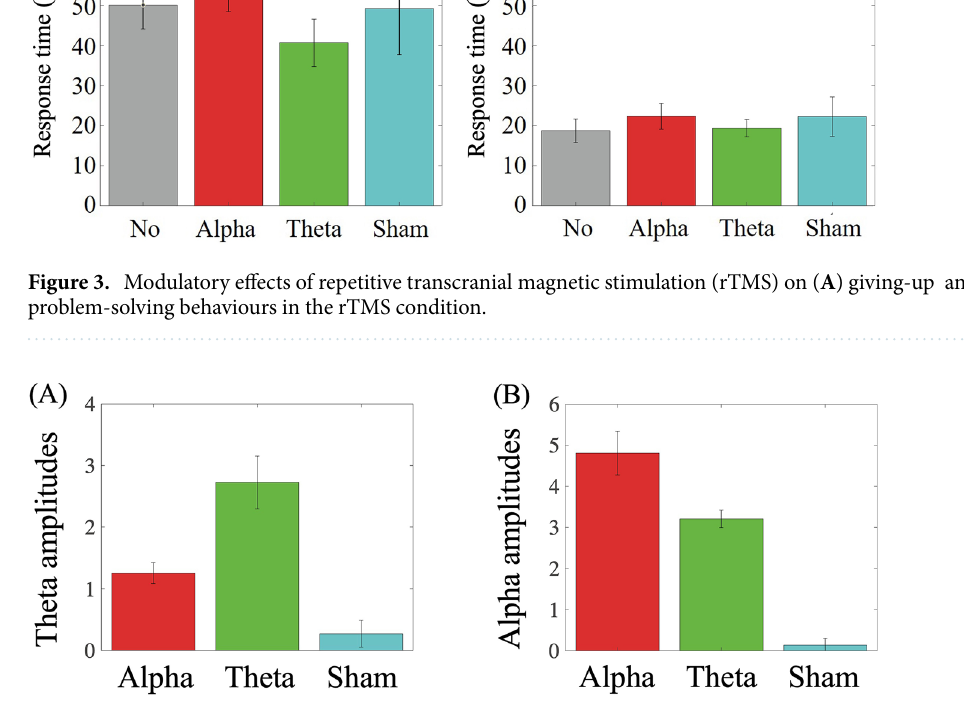
Figure 4. Modulatory effects of repetitive transcranial magnetic stimulation (rTMS) on ( A ) theta and ( B ) alpha amplitudes for the rTMS